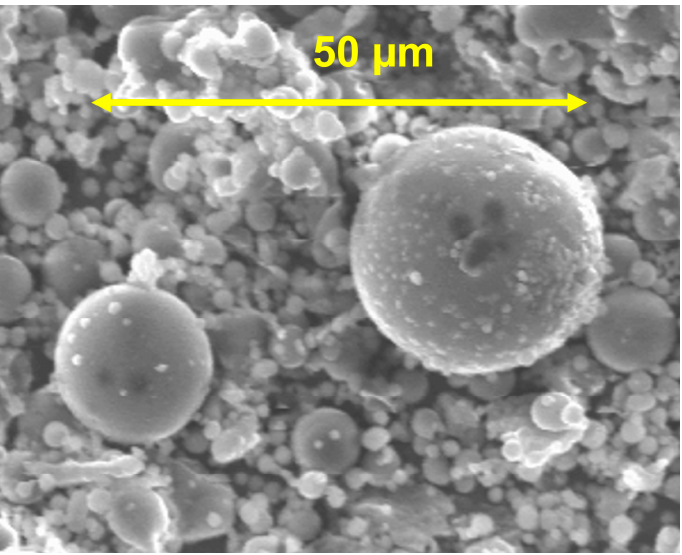
Figure 1. SEM image of coal fly ash particles.